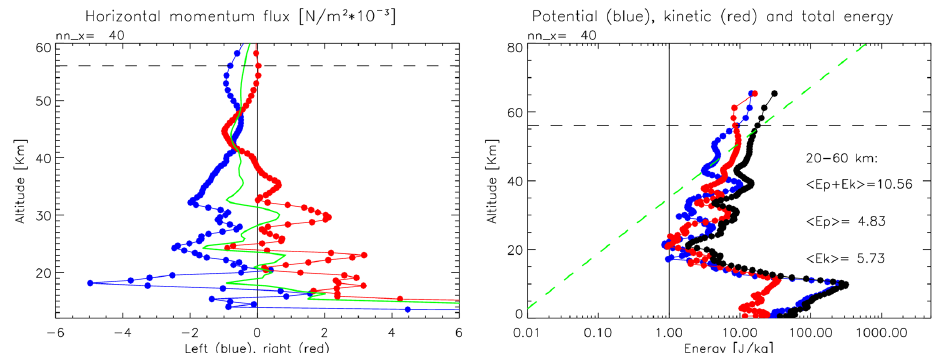
Figure 10. Left panel: spatial average of horizontal momentum flux (10 − 3 Nm − 2 ) on the left side (blue), right side (red) and whole domain (green), within a square of ± 40 grid boxes (i.e. ± 120km on both x and y direction) from OHP. Right panel: spatial average of potential (blue), kinetic (red) and total (black) energy (Jkg − 1 ); 21 October 2012, at 23:00UTC of (coincident with the peak of thunderstorm intensity). Vertically averaged values of total, potential and kinetic mean energy are reported in Jkg − 1 . Green dashed line represents conservative growth